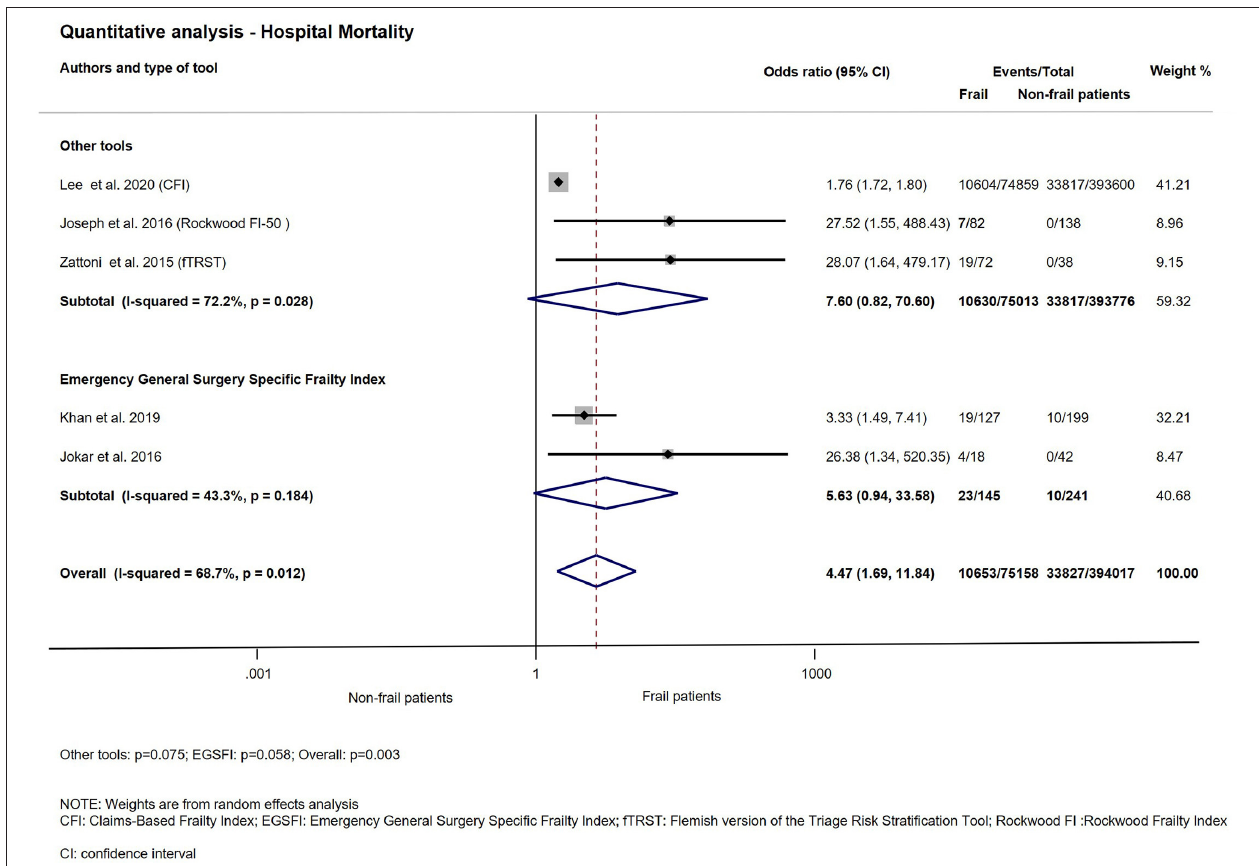
FIGURE 5 | Quantitative analysis with subgroup analysis—Hospital mortality. For patients living with frailty, the overall OR of hospital mortality was 4.47; CI: 1.69–11.84. In the EGSFI subgroup frail patients have higher odds of hospital mortality (OR: 5.63; CI: 0.94–33.58). In the Other tools subgroup, the OR of hospital mortality was 7.60; CI: 0.82–70.60. Note that the overall heterogeneity and the heterogeneity for any other tools was substantial, but for EGSFI was moderate.